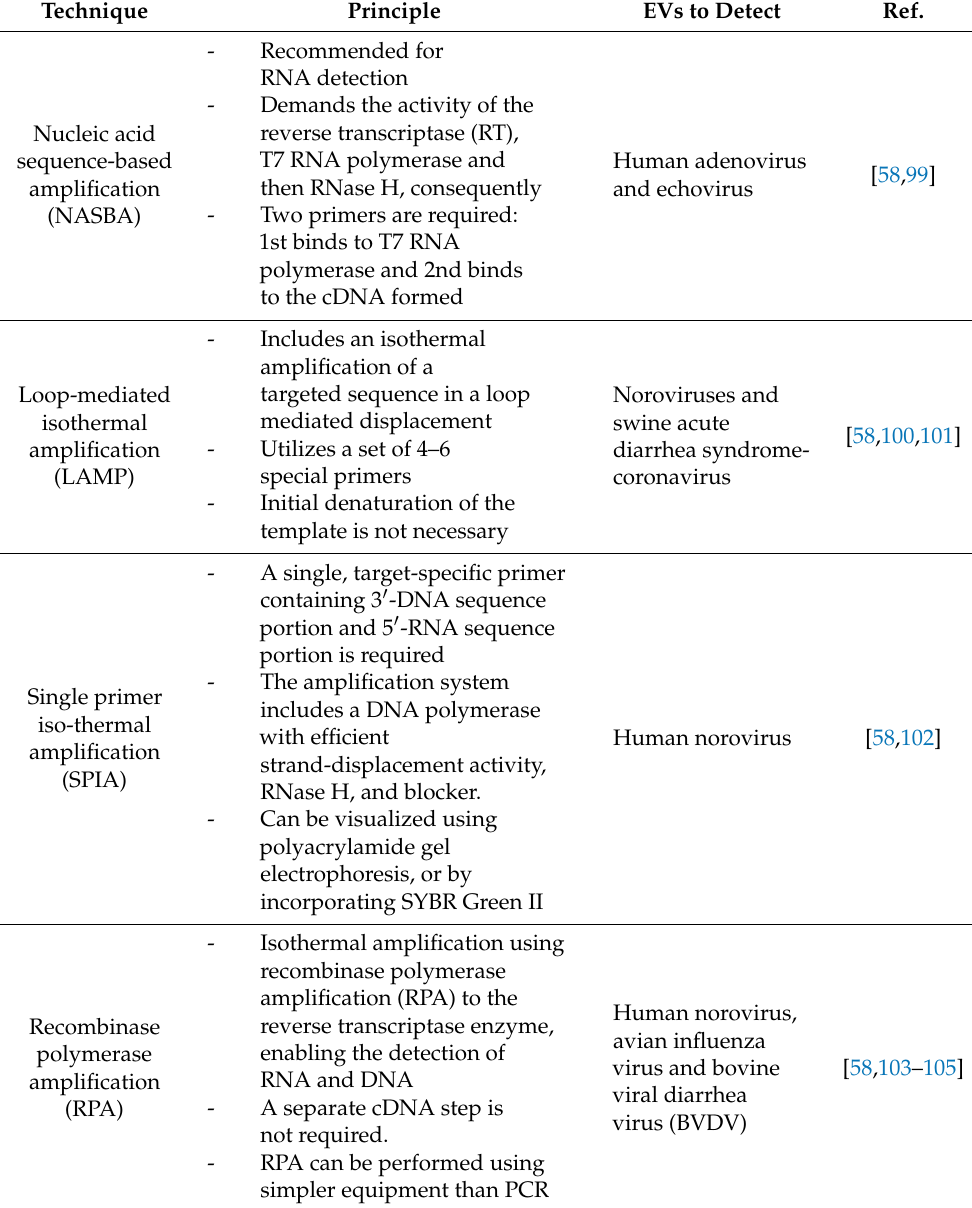
Table 3. Isothermal nucleic acid amplification-based